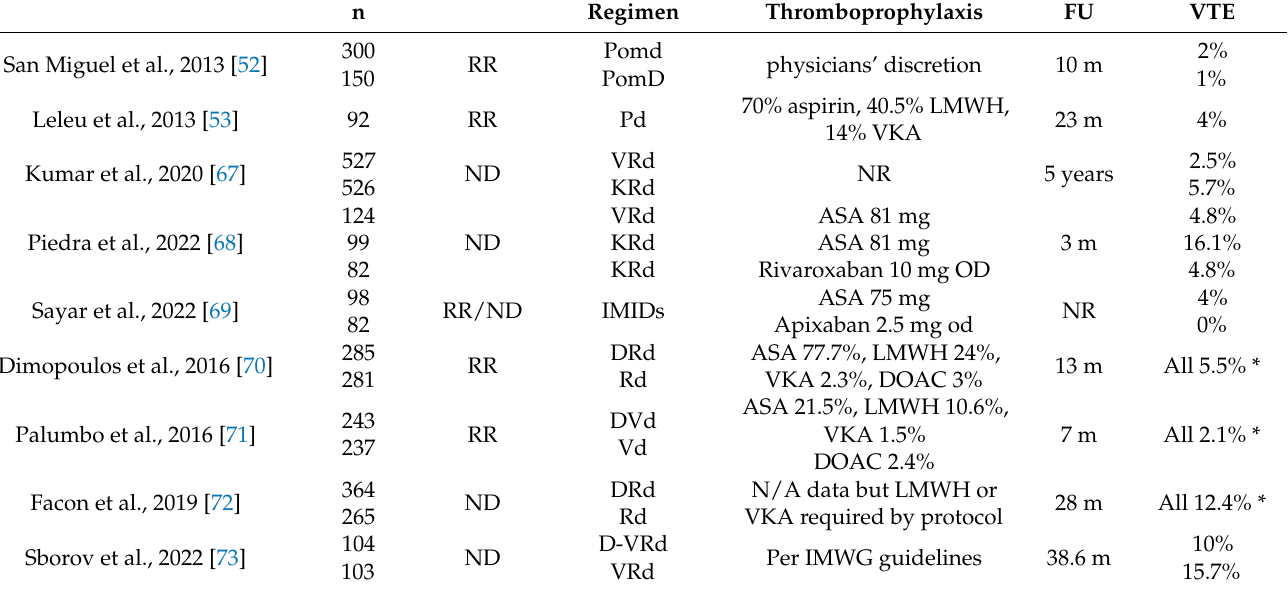
Table 1. Cont. n Regimen